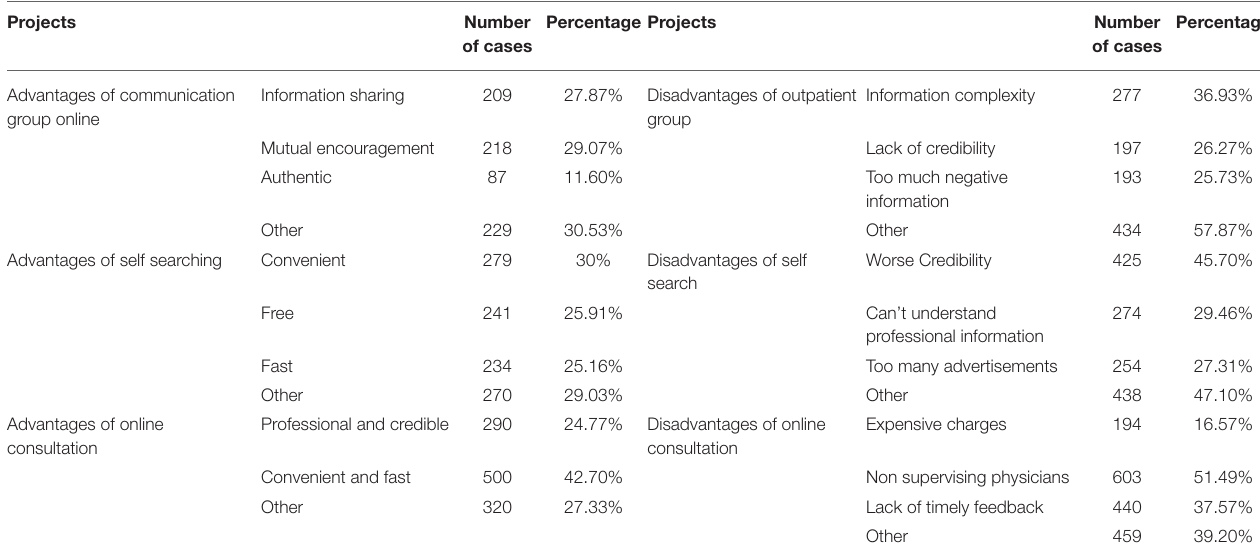
TABLE 3 | Evaluation of domestic internet medical applications by oncology